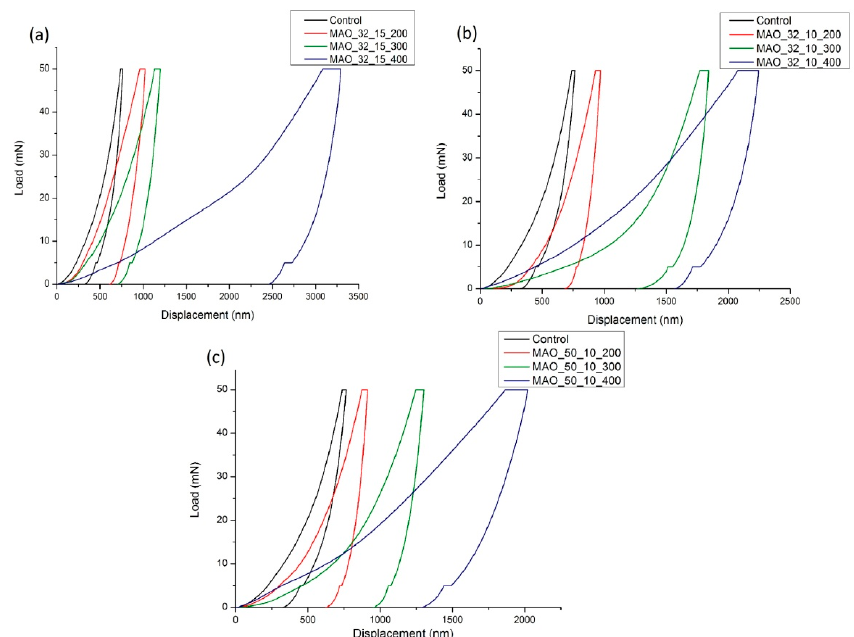
Figure 7. Nanoindentation load-displacement curve obtained for the investigated MAO coatings with various MAO process parameters and control specimens obtained by the nanoindentation test ( a – c ): MAO_32_15 ( a ), MAO_32_15 ( b ), and MAO_32_15 ( c ) (the presented results are representative for twenty-five analyses of each surface treatment specimens).